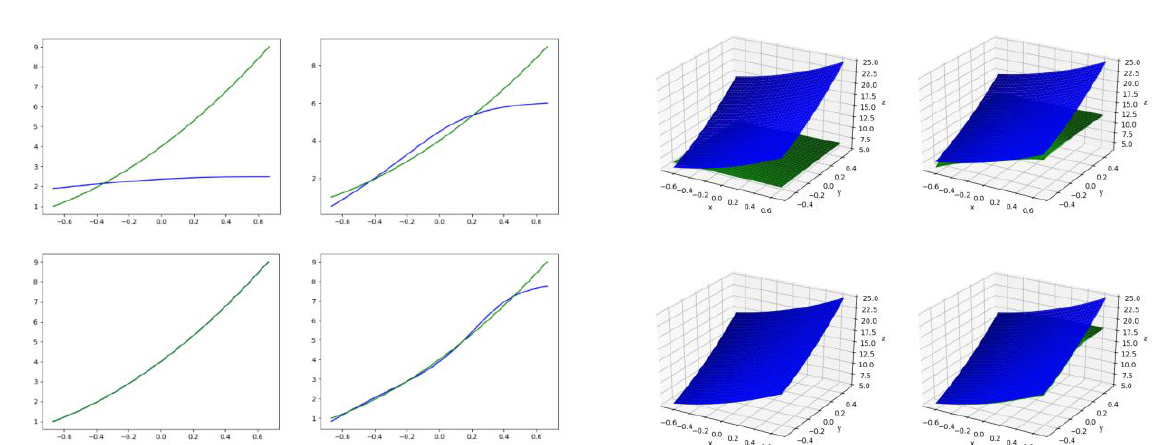
Figure 3. Fitting quadratic functions with one (left, clockwise from top left) and two (right, clockwise from top left)